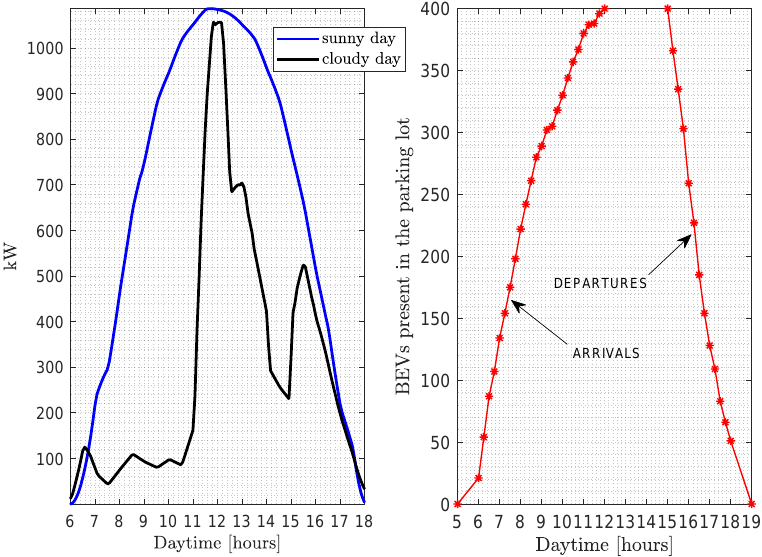
Figure 10. Daily solar power curves ( u W ) for charging 400 BEVs and arrivals/departures of a fluctuating population of 400 BEVs in the parking